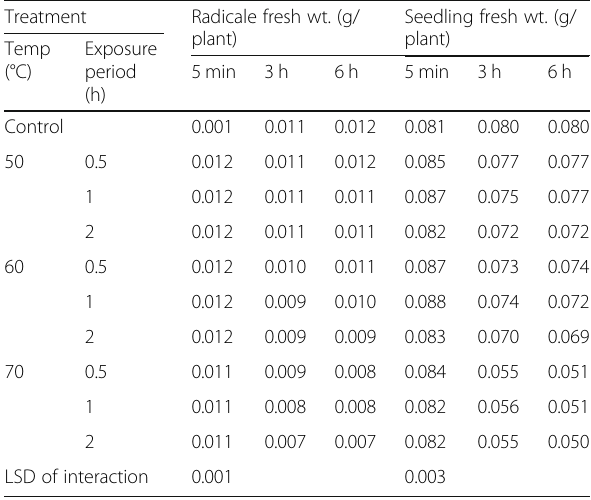
Table 3 Effect of seed hardening on radicale fresh weight (g/ plant) and seedling fresh weight (g/plant) Treatment Radicale fresh wt. (g/ plant)